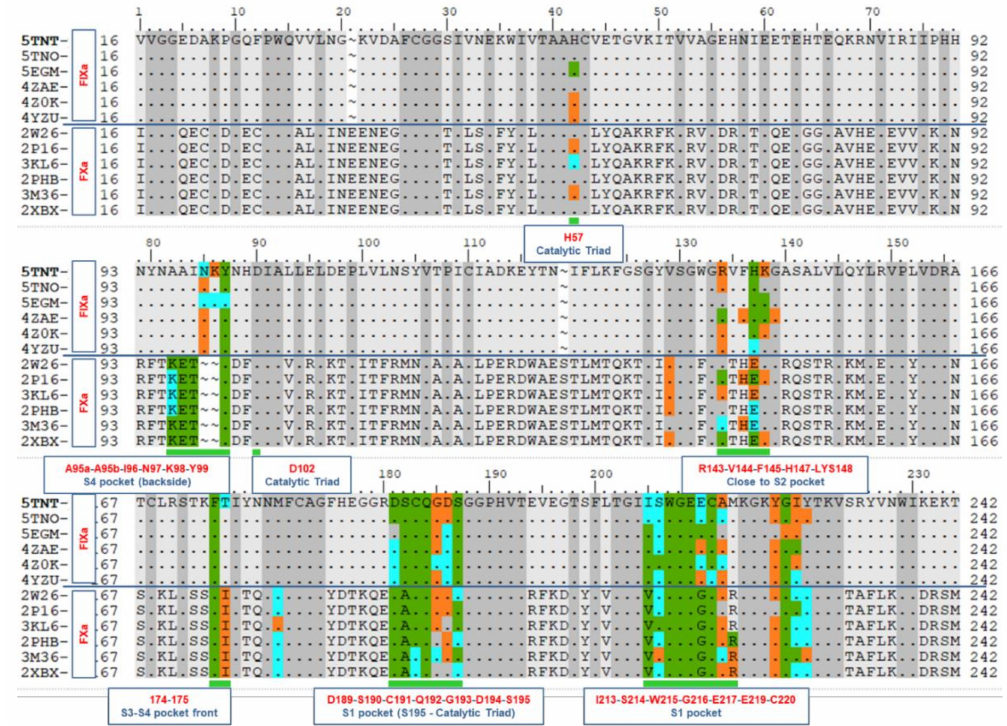
Figure 2. Human coagulation factor IXa and factor Xa sequence comparison were performed to identify the conserved residues within these two sets of proteins. There are 12 rows in this alignment representing 12 proteins. The first 6 are FIXa and next 6 are FXa. The dots represent the identical residues. The residues marked green indicates that they are within the distance of 3 Å from their corresponding ligands. Similarly, cyan represents residues within 4 Å and orange within 5 Å